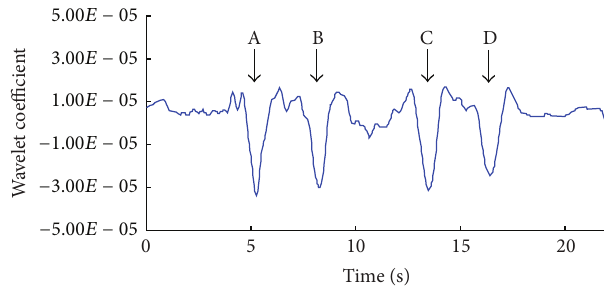
Figure 9: Wavelet transform of vehicle displacement when two cracks are considered at 𝐿 /3 and 2 𝐿 /3 of the beam with 30% crack depth and speed of 2m/s. (A: first axle passing 𝐿 /3, B: second axle passing 𝐿 /3, C: first axle passing 2 𝐿 /3, and D: second axle passing 2 𝐿 /3), after